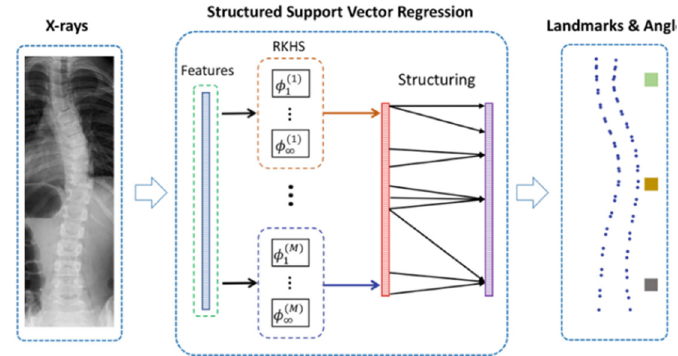
Figure 5. The framework of S 2 VR [64]: SVR is used to capture the angle and landmark output correlation structure matrix, improved to obtain S2VR. Sun, H. et al. [64] introduced manifold regularization and trained with kernel alignment method.